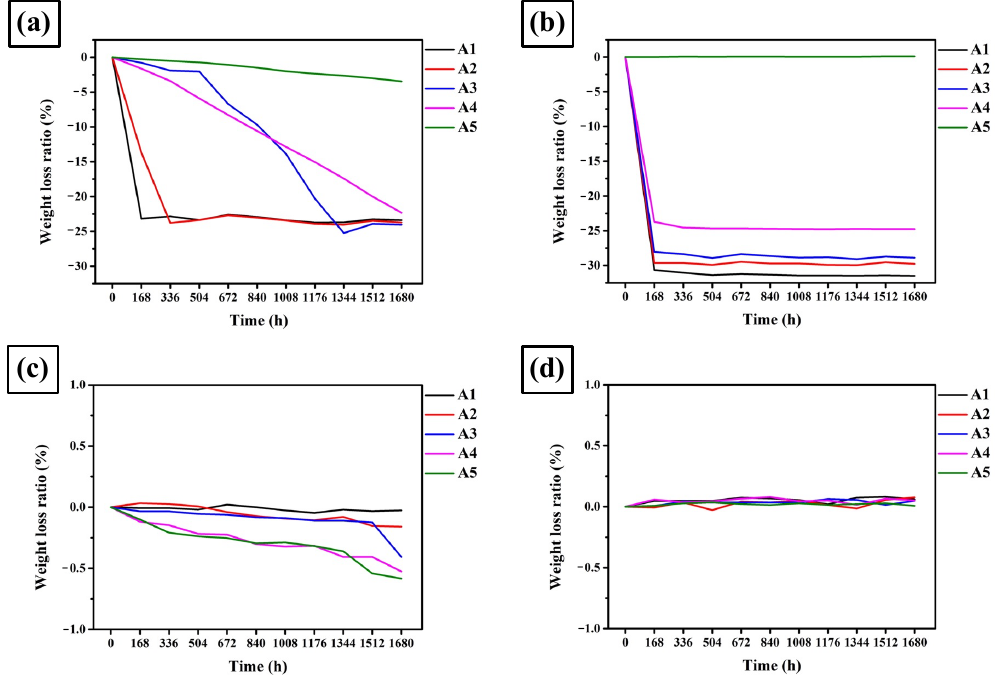
Figure 9. Mass loss ratio of A1, A2, A3, A4, and A5 in corrosive solutions: ( a ) 1.5 M HCl (aq) , ( b ) 1.5 M H 2 SO 4(aq) , ( c ) 1.5 M HNO 3(aq) , and ( d ) 1.5 M C 6 H 8 O 7(aq) .